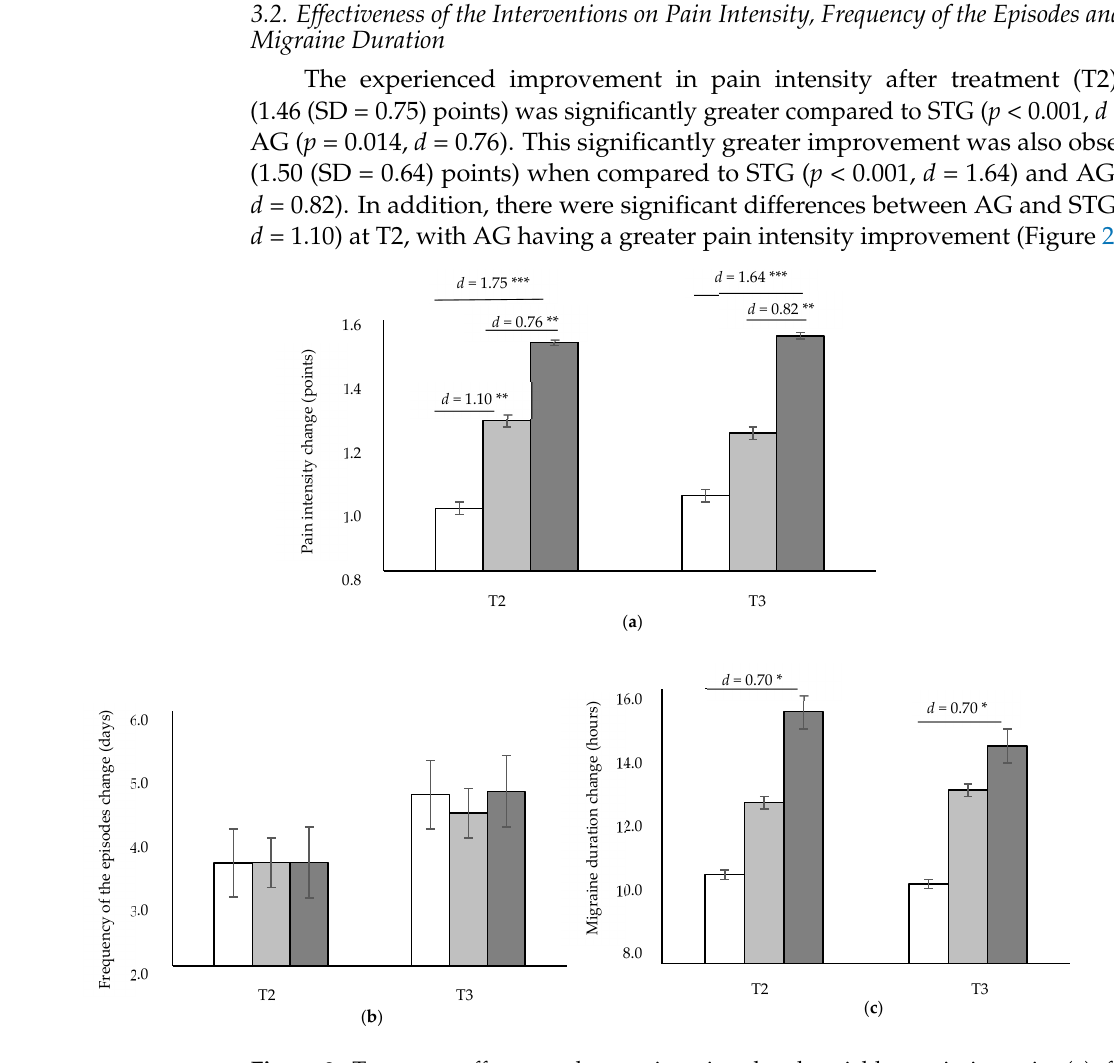
Figure 2. Treatment effects on changes in pain related variables: pain intensity ( a ), frequency of episodes ( b ) and migraine duration ( c ). Bars and error bars show the mean change experienced and SDs. White bars represent the soft tissue group, pale grey bars represent the articulatory group, whereas dark grey bars show the soft tissue and articulatory group. * p < 0.05; ** p ≤ 0.01; *** p ≤ 0.001. d : Cohen’s effect size (only for the significant comparisons).